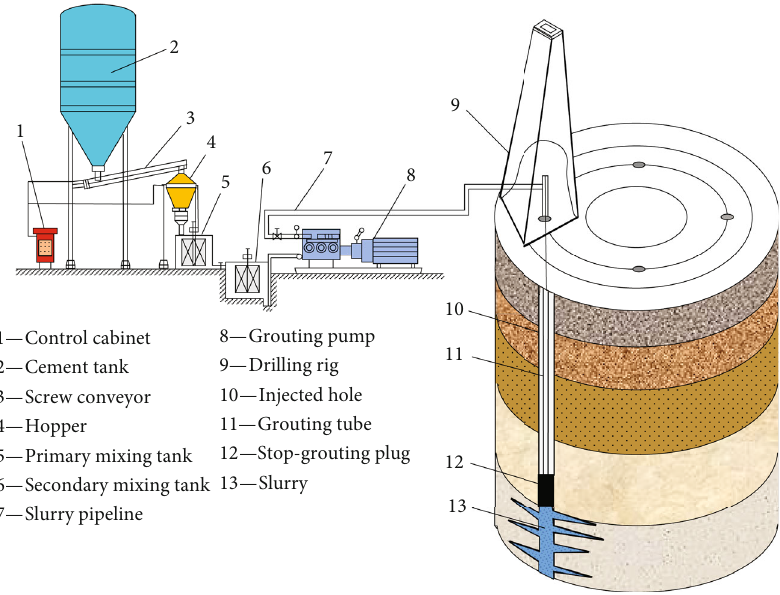
Figure 4: Vertical shaft ground drilling grouting. Table 1: Physical parameters of the core soil samples taken from the 3rd wind inspection